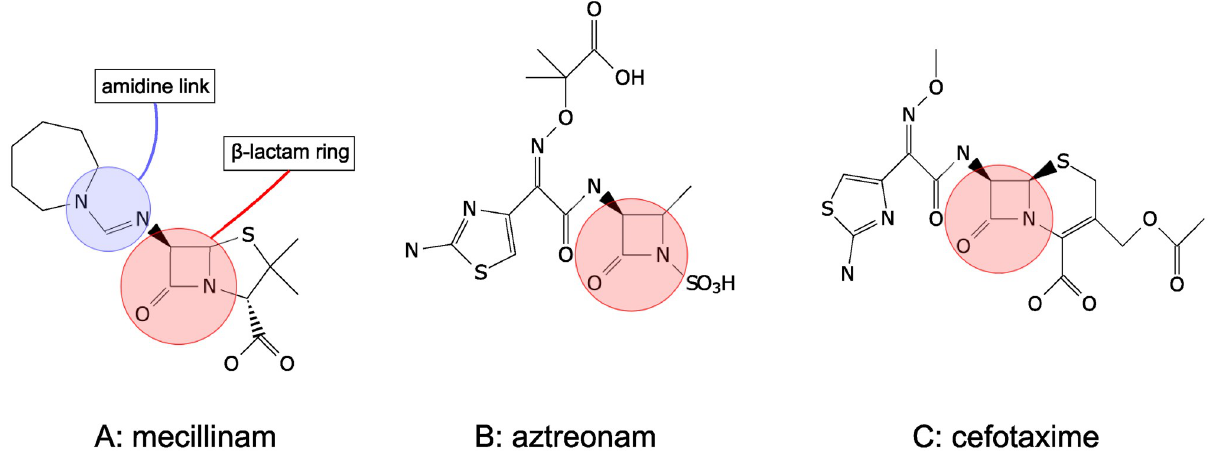
Fig 1. Chemical structures of mecillinam, aztreonam and cefotaxime. A: Mecillinam has a characteristic penicillin structure with a fused beta- lactam-thiazolidine two-ring system [39] and an amidine link to the side chain. B: Aztreonam has a monobactam structure with no secondary ring attached to the β -lactam ring, and with an N-SO 3 H side-chain [35]. C: Cefotaxime has a characteristic cephalosporin structure with a fused β -lactam- Δ 3 -dihydrothiazine two-ring system [39]. All structures were drawn using the chemfig Latex package.